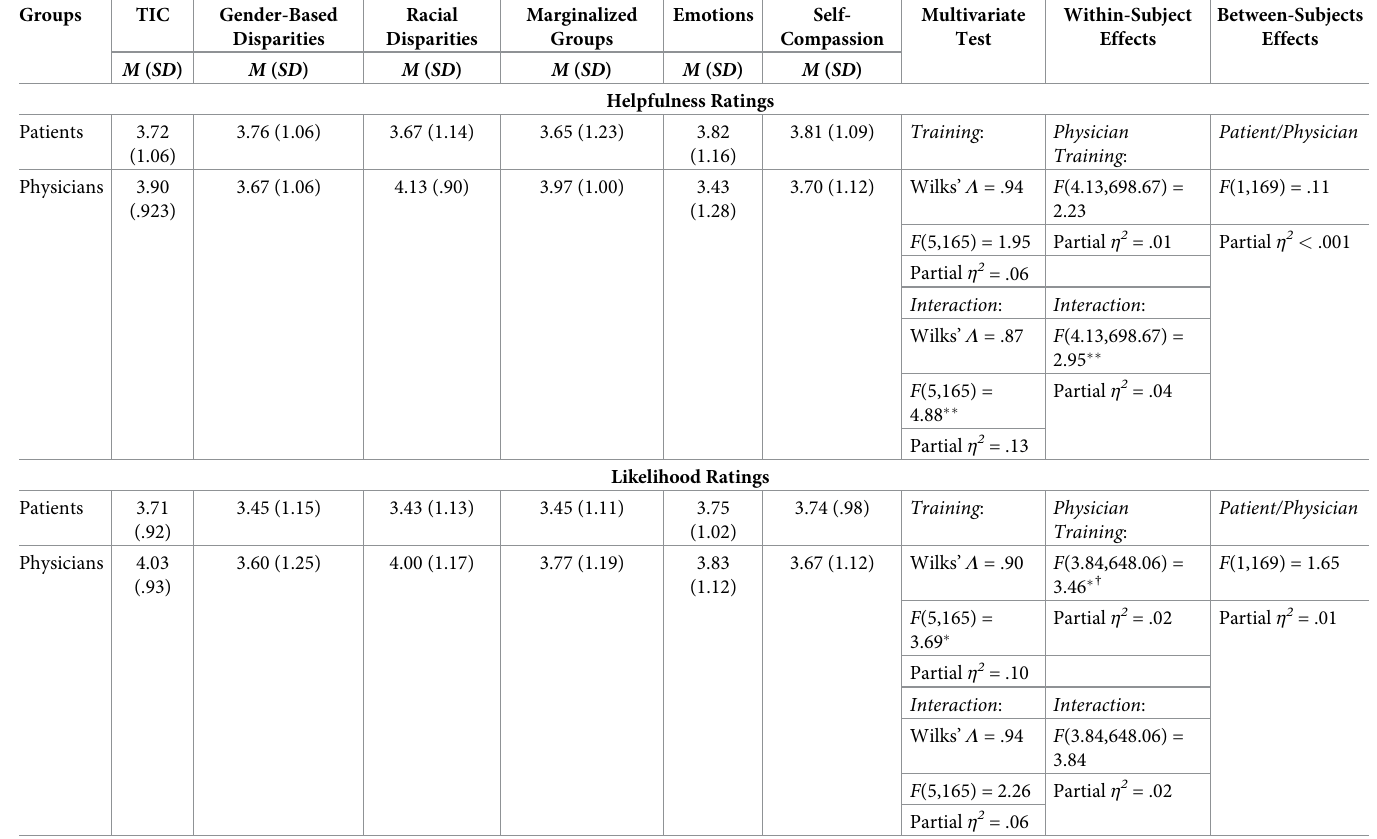
Table 3. Repeated measures ANOVA for patients’ and physicians’ opinion on physician